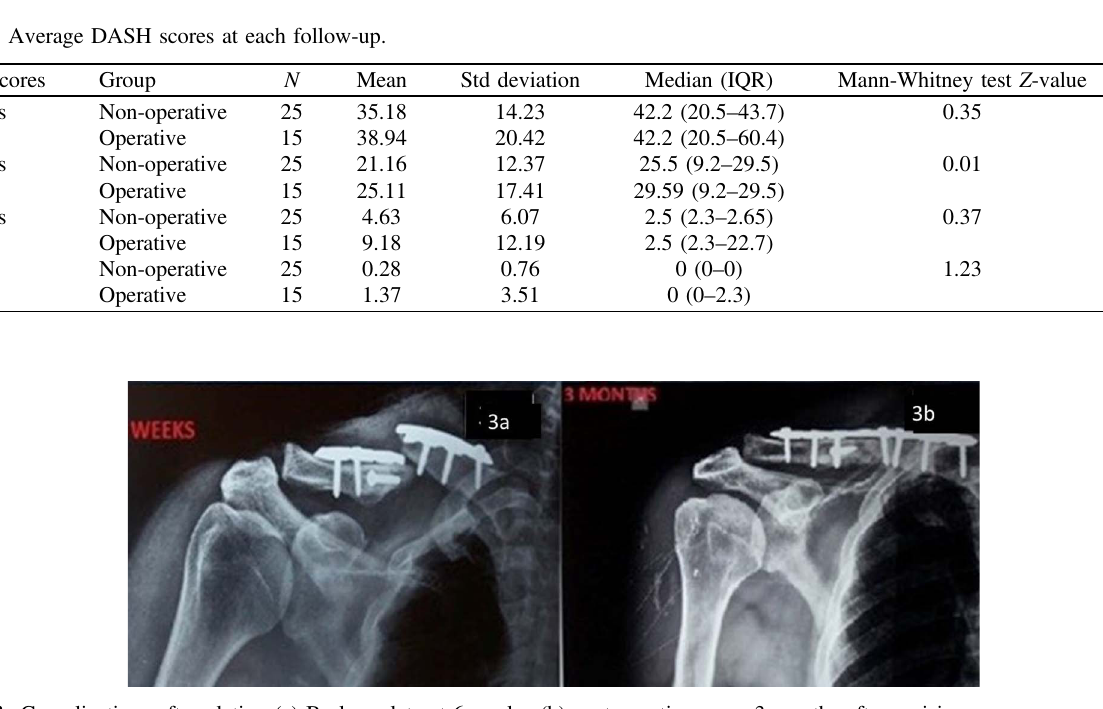
Figure 3. Complications after plating (a) Broken plate at 6 weeks, (b) postoperative x-ray 3 months after revision